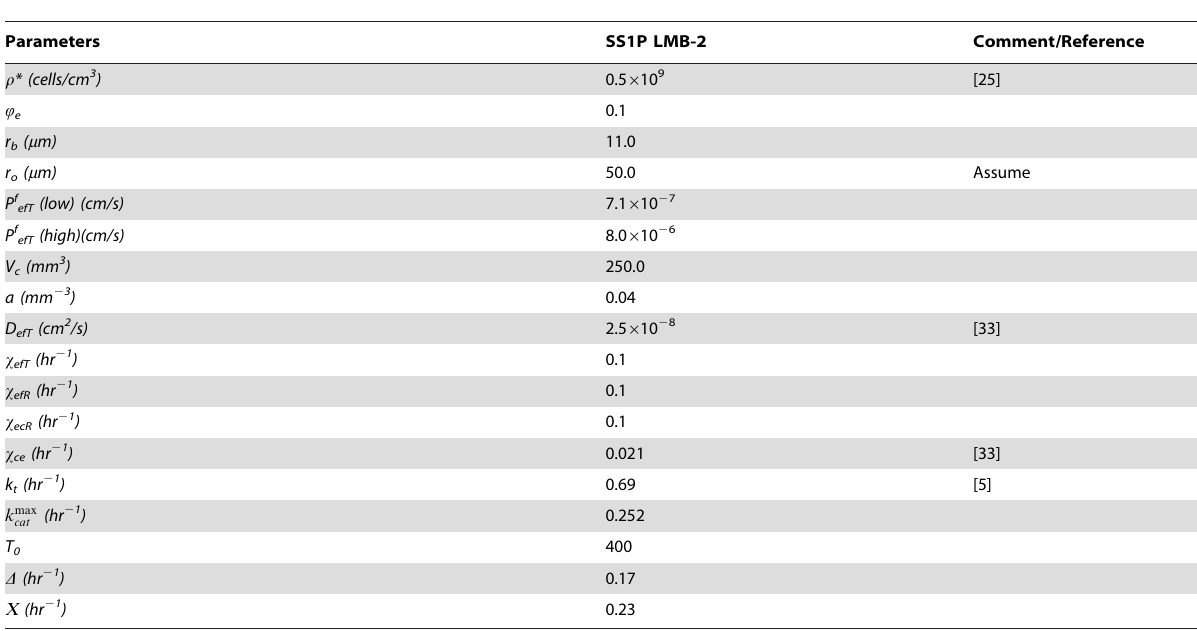
Table 2. Parameters that were unchanged between SS1P and LMB-2.